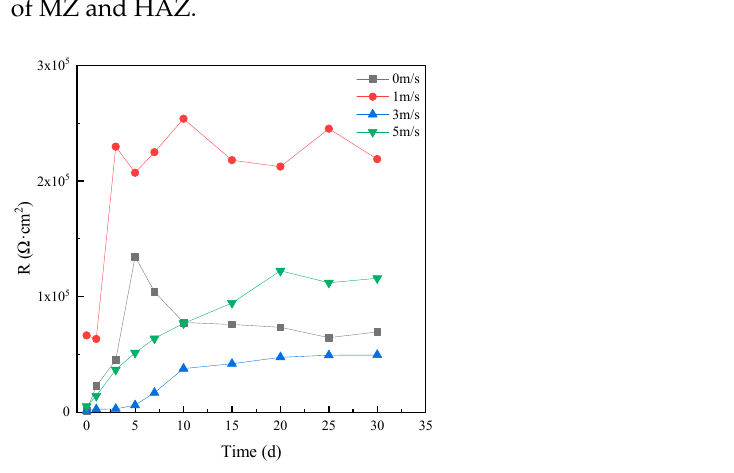
Figure 12. Work potential distribution of welding joints. 3.3.2. Galvanic Potential and Current Testing HAZ and WZ were connected with an area ratio of 1:1, then the galvanic current was measured in different flowing rates of seawater, and the measuring result is shown in Figure 13. From Figure 13, we can see that galvanic current density quickly decreased with time, increasing due to the formation of protective corrosion production. After 3 days, the galvanic current density was nearly zero, indicating that galvanic corrosion did not occur. However, at the beginning of the experiment, the galvanic current density was 4.43 μ A/cm 2 in 5 m/s seawater, that is to say, galvanic corrosion occurred without protective